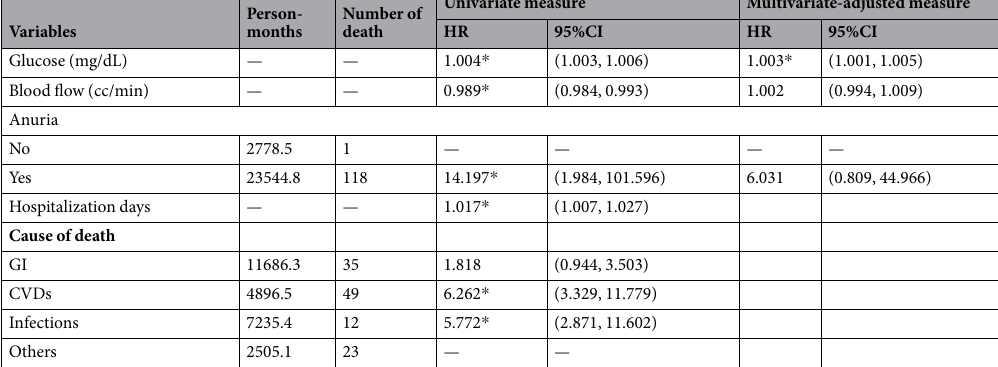
— — Table 2. Factors associated with 4-year all-cause mortality of the hemodialysis patients. HD: hemodialysis; A-V: arteriovenous; EPO: erythropoietin; iPTH: intact parathyroid hormone; URR: urea reduction ratio; HBV: hepatitis B virus; HCV: hepatitis C virus; nPCR: normalized protein catabolic rate; TACurea: time-averaged concentration of urea * p-value < 0.05 in the univariate and multivariate-adjusted